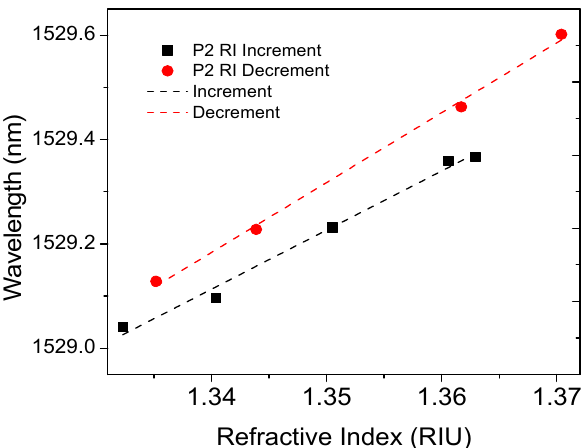
Figure 7. Loop hysteresis analysis for refractive index variation using the P2 peak.